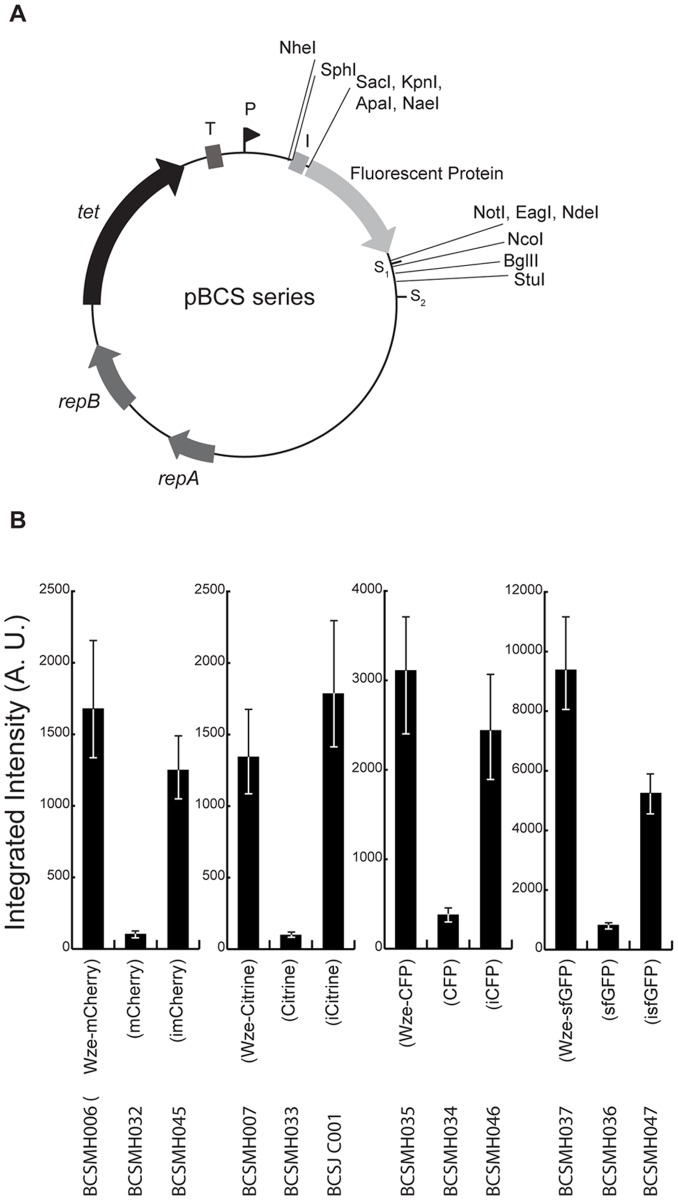
New plasmids for S. pneumoniae cell biology studies.(A) Map of the pBCS plasmids. Fluorescent protein refers to mCherry, Citrine, CFP or GFP, encoded by plasmids pBCSMH030, pBCSJC001, pBCSMH031 and pBCSMH032, respectively. ApaI and NaeI restriction sites, highlighted with an asterisk, are not available in plasmid pBCSMH030. repA, repB, plasmid replication genes. tet, tetracycline resistance marker. T, transcription terminator. P, promoter. S1, stop codon in plasmid pBCSMH030. S2, stop codon in plasmids pBCSJC001, pBCSMH031 and pBCSMH032. (B) Comparison of fluorescence emitted by strains expressing mCherry, Citrine, CFP and GFP alone, their improved i-tag versions and their Wze fusions. The median fluorescence, with 25% (white error bars) and 75% (black error bars) inter-quartile range (in arbitrary units) is plotted. At least 100 cells of each strain were quantified. Strain names are indicated below.